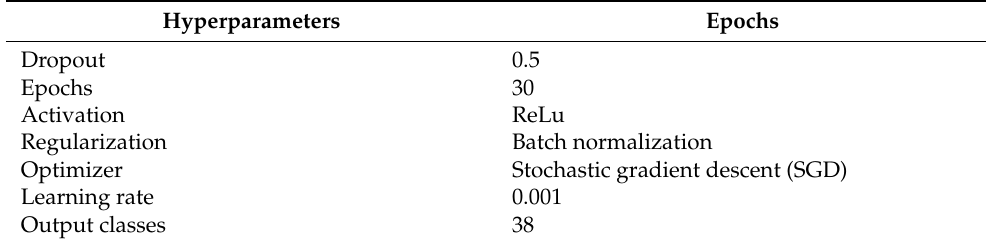
Table 3. Hyperparameter specifications.